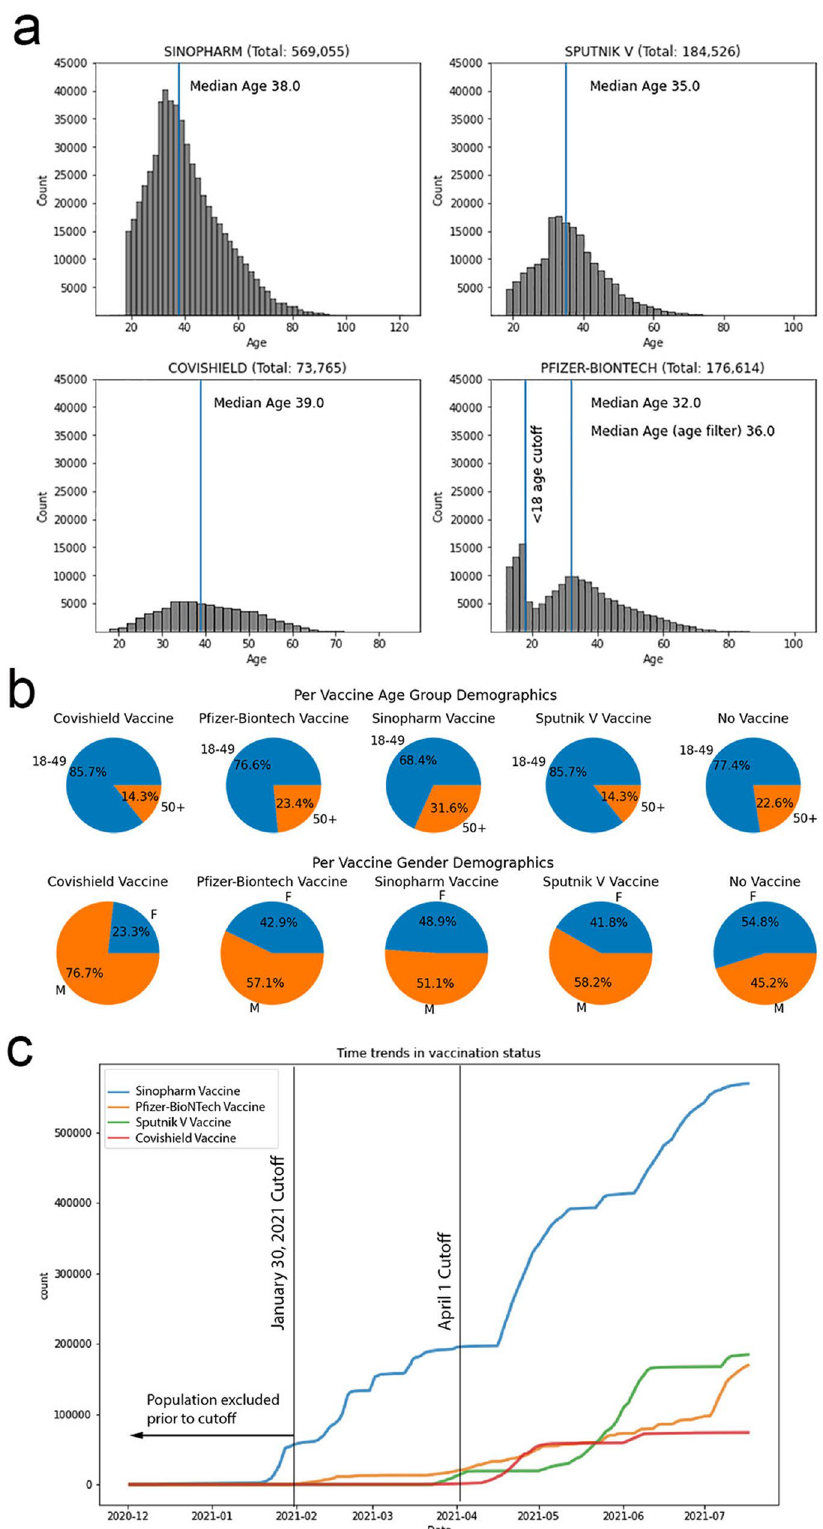
Figure 1. Distribution of Covid vaccines. ( a ) Age distributions of the four different vaccines administered in the population. Pfizer- BioNTech was the only vaccine given to ages 12–18 < 18 years of age, and those data were excluded from the analysis. ( b ) Age and gender demographics for all vaccines. Note that all individuals less than 18 years were eliminated from these pie charts and from the analysis below. ( c ) Visualization of the vaccine rollout. The curves display the counts of individuals that have presumptive protection (i.e. 14 days after the second booster dose) for each of the four vaccines on each day. January 30th is the date that the first Pfizer recipients achieved presumptive protection (i.e. 14 days after their second Pfizer vaccination dose) and is therefore used as a cutoff to censor any early recipients of Sinopharm. April 1 is the cutoff date for the deployment of the AZ/Covishield and Sputnik V vaccine, and was similarly used in any comparison between these vaccines and Sinopharm (see Supplementary Table